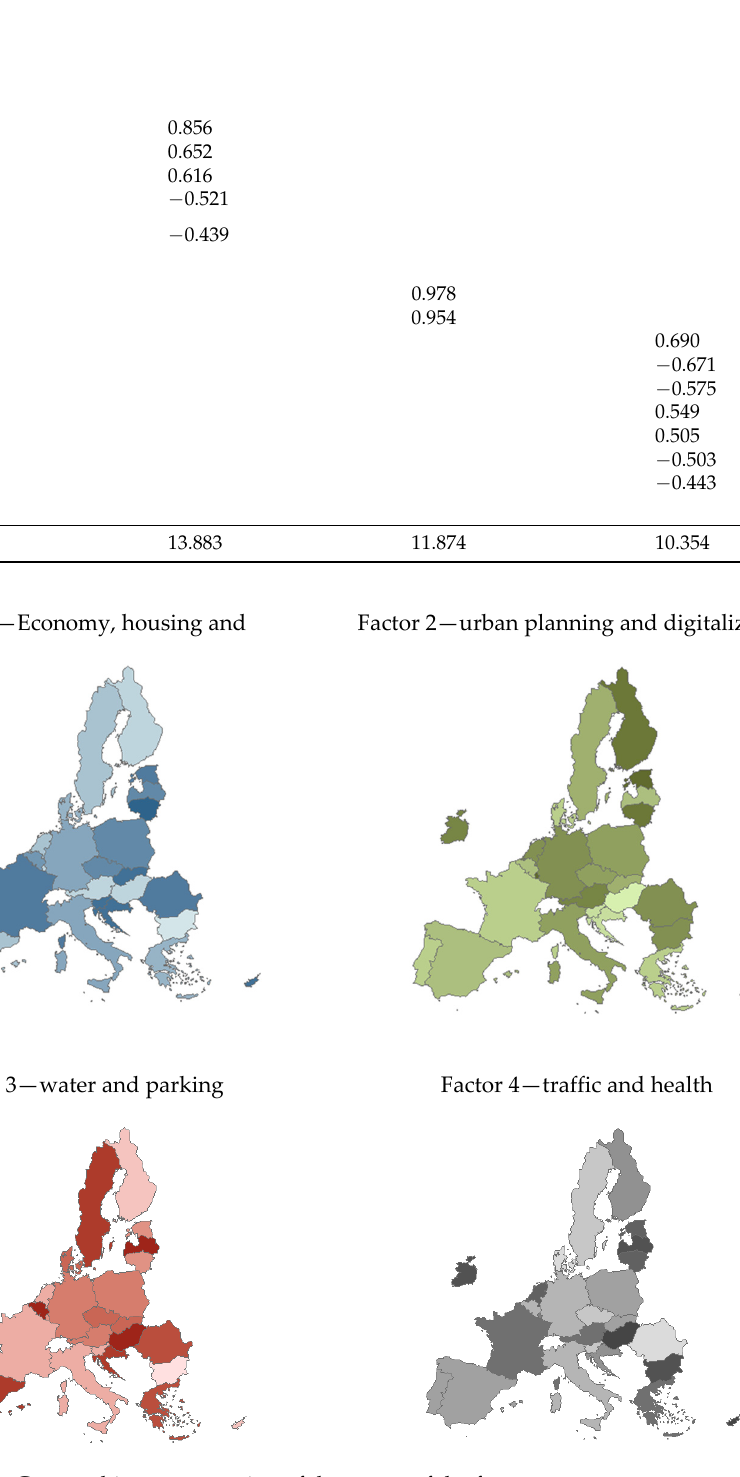
Figure A2. Geographic representation of the scores of the factors.